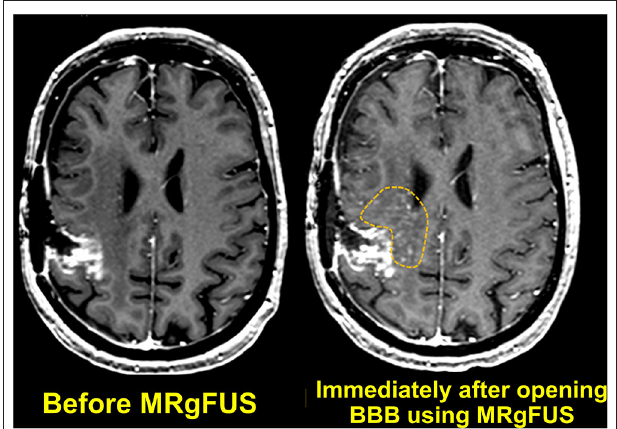
FIGURE 11 | Axial T1-weighted MR images obtained before and immediately after MRgFUS was used to open the BBB. Localized extravasation (inside the dotted yellow circle) can be seen in the predefined targeted brain